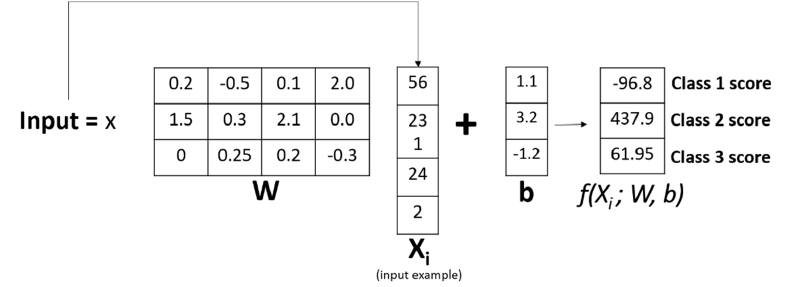
Figure 2. Example of score function.